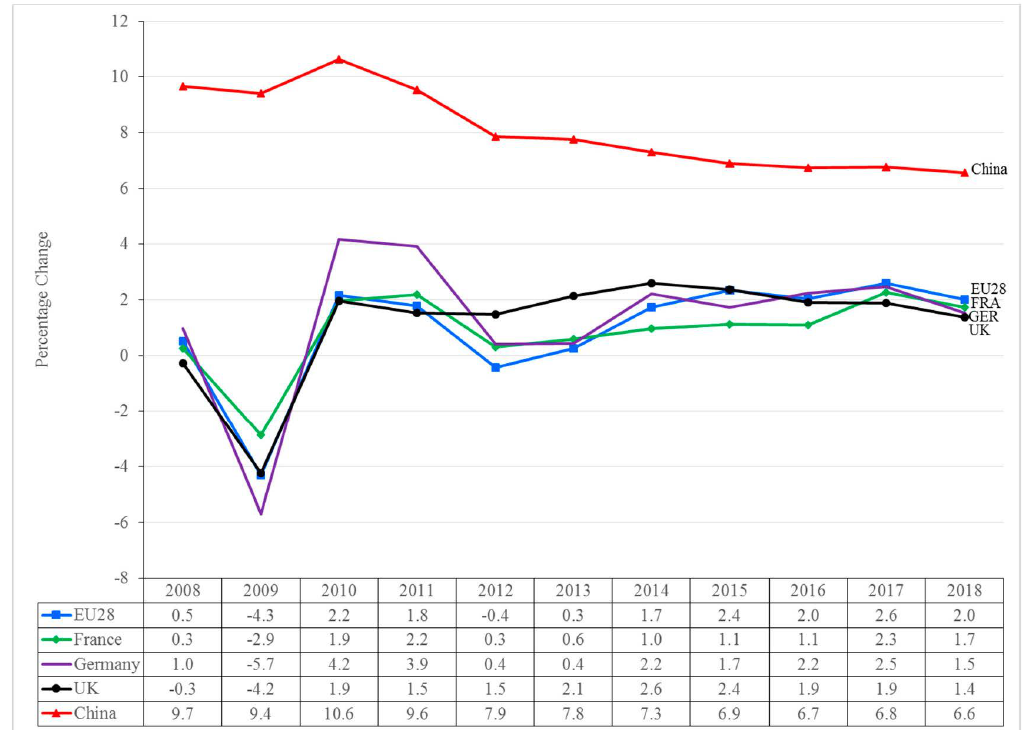
Figure 2 GDP annual growth (%), 2008–18. Source: The World Bank, ‘DataBank’ (2020) <http://databank. worldbank.org/data/home.aspx> accessed 27 February 2020.